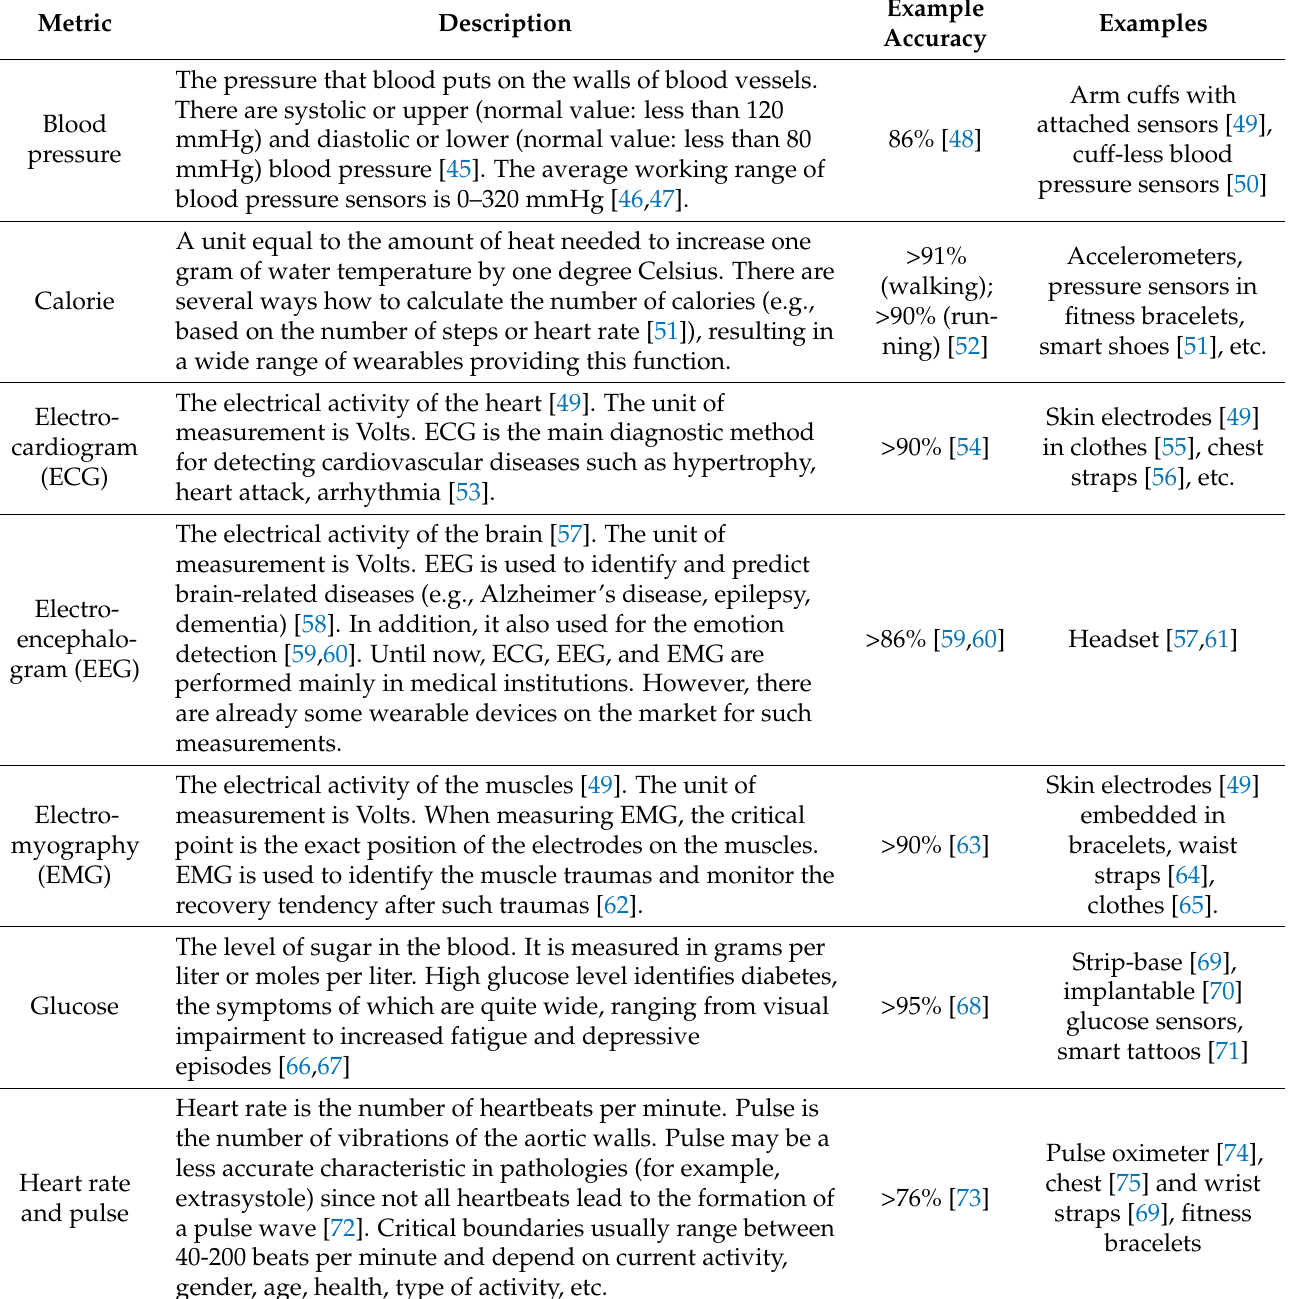
Table 3. Human body-related